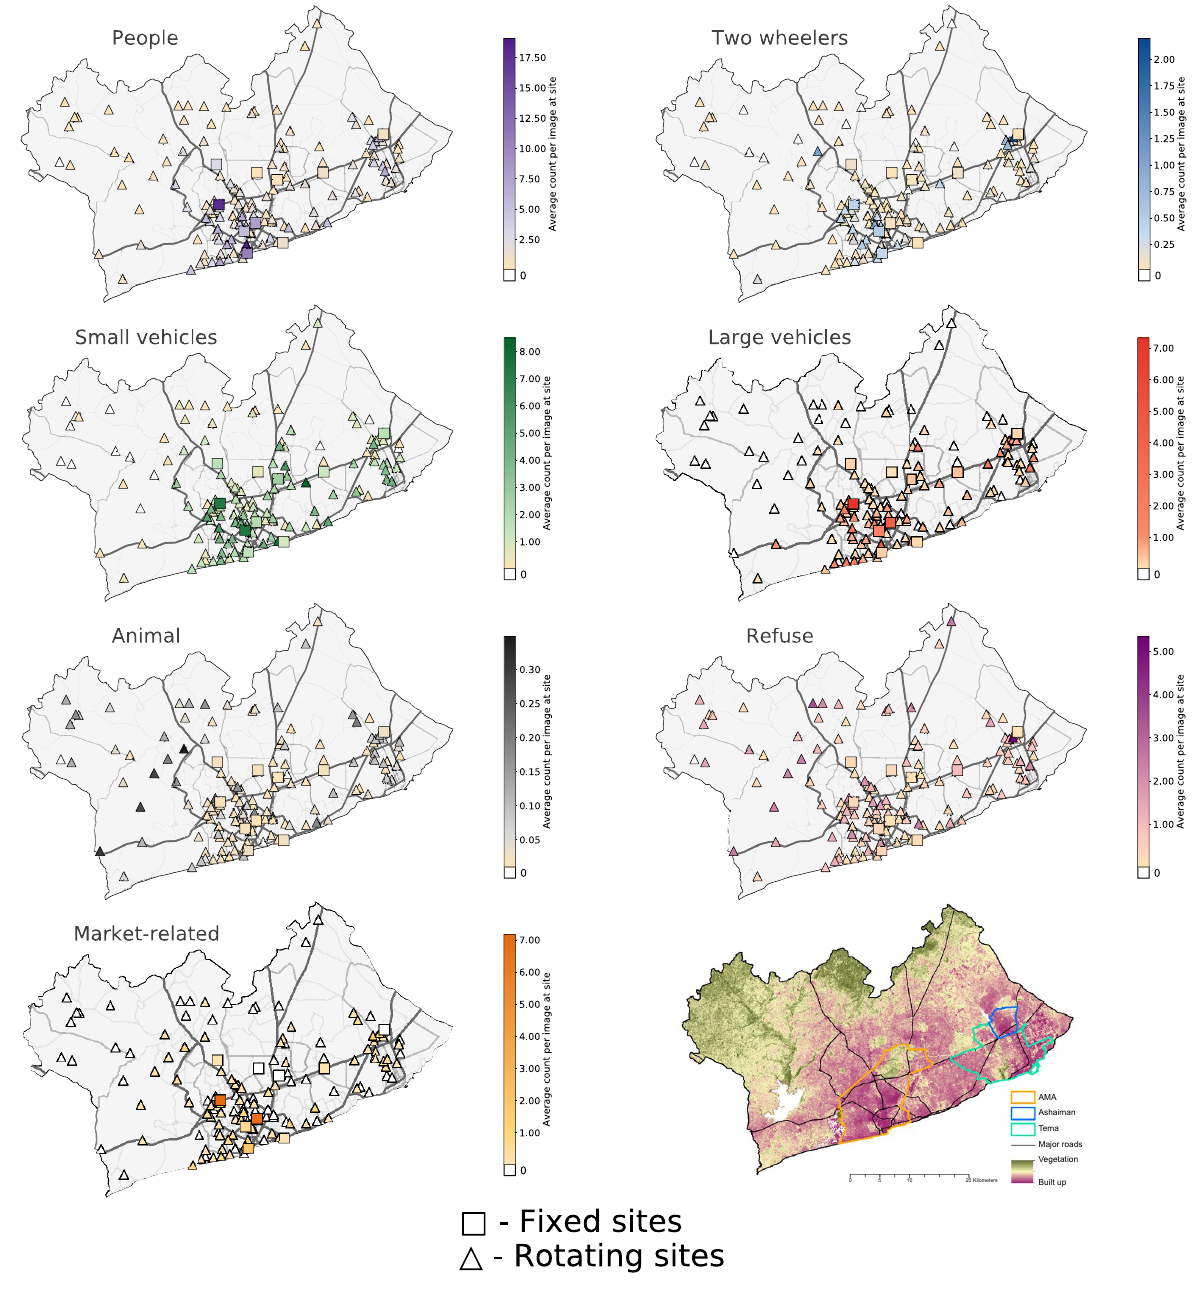
Figure 5. Location of image collection sites and object counts at each site. The 20 objects are categorised into: people (persons and market vendors); large vehicles (lorries, vans, tro tros and buses); small vehicles (cars, taxis and pick-up trucks); two wheelers (bicycles and motorcycles); objects from the market (umbrellas, market stalls, cookstoves, cooking pots/bowls, food and loudspeakers); refuse (trash and debris); and animals. Squares on the maps show the fixed sites and triangles the rotating sites. For each measurement site and object category, the mean number of objects per image is shown. For sites with two cameras, the number shows the mean per image across both cameras. Dark grey lines show major roads and light grey lines secondary and tertiary roads. Road network data are from OpenStreetMap (2019) and the Greater Accra Metropolitan Area (GAMA) boundary, as well as those of Accra Metropolitan Area (AMA), Ashaiman and Tema, from the Ghana Statistical Service. The bottom right panel map shows how much an area is built-up versus those that are abundant with vegetation, as represented by the Normalised Difference Vegetation Index (NDVI) derived from Landsat 8 Satellite images